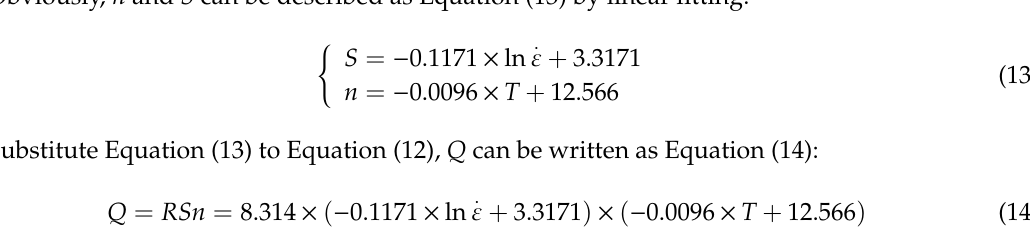
Figure 5. Relationship between activation energy and deformation parameters.( a ) T–n , ( b ) ln - S